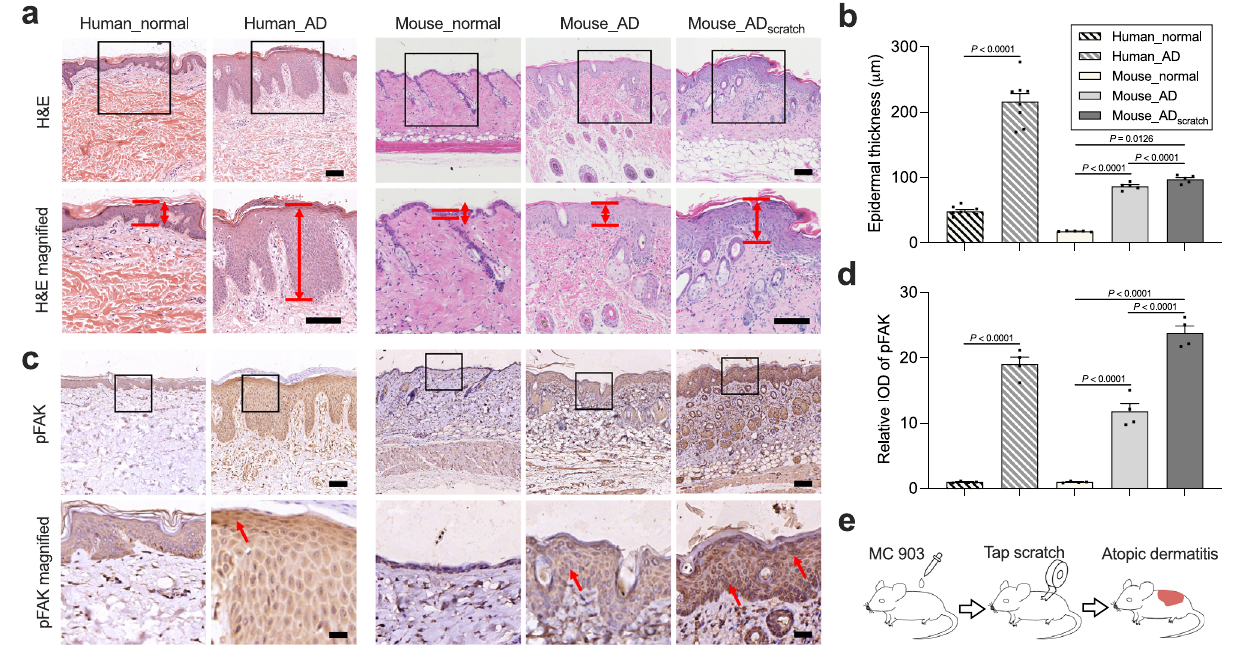
Fig. 2 | pFAK is upregulated in AD skin, especially after scratching. a Representative hematoxylin and eosin (H&E) staining of skin section of humans and mice. The black boxed area is enlarged below. The space between red lines denotes the epidermal thickness. Scale bar, 100 μ m. b Epidermal thickness quan- ti fi ed from H&E staining in ( a ), For human skin, n =8. For mouse skin, n =5. c Immunohistochemistrystaining ofpFAK in each group. Scalebar,100 µ m for the